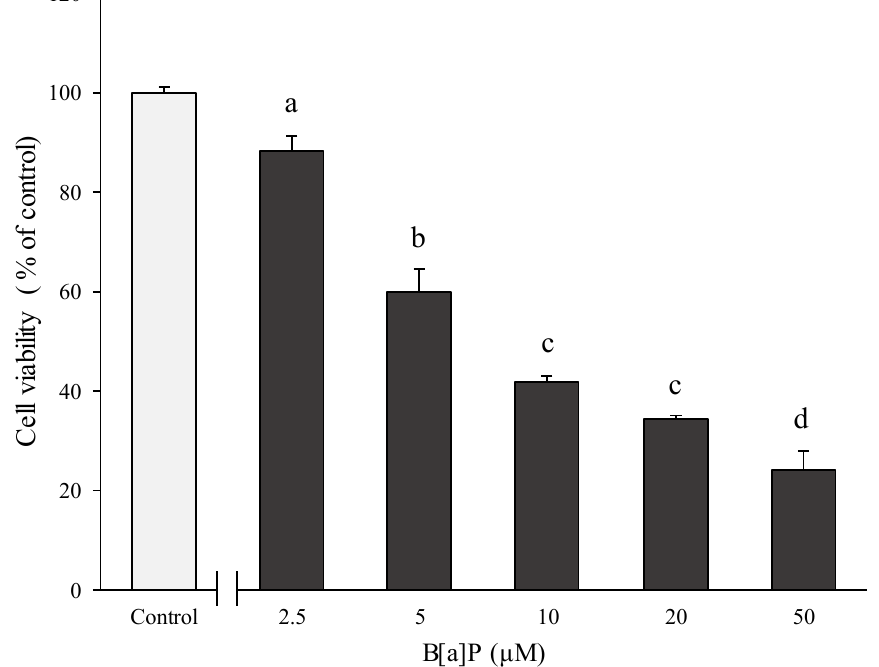
Figure 3. Effects of B[ α ]P on cell viability (% of control). The human brain microvascular endothelial cells (HBMECs) were treated with different concentrations of B[ α ]P for 24 h. The values are mean ± SD in triplicate. Each bar with different letters is significantly different. a p < 0.01 as compared with control; b p < 0.001 as compared with control; c p < 0.001 as compared with control; d p < 0.001 as compared with control. Control indicates HBMECs treated by DMEM without B[ α ]P.